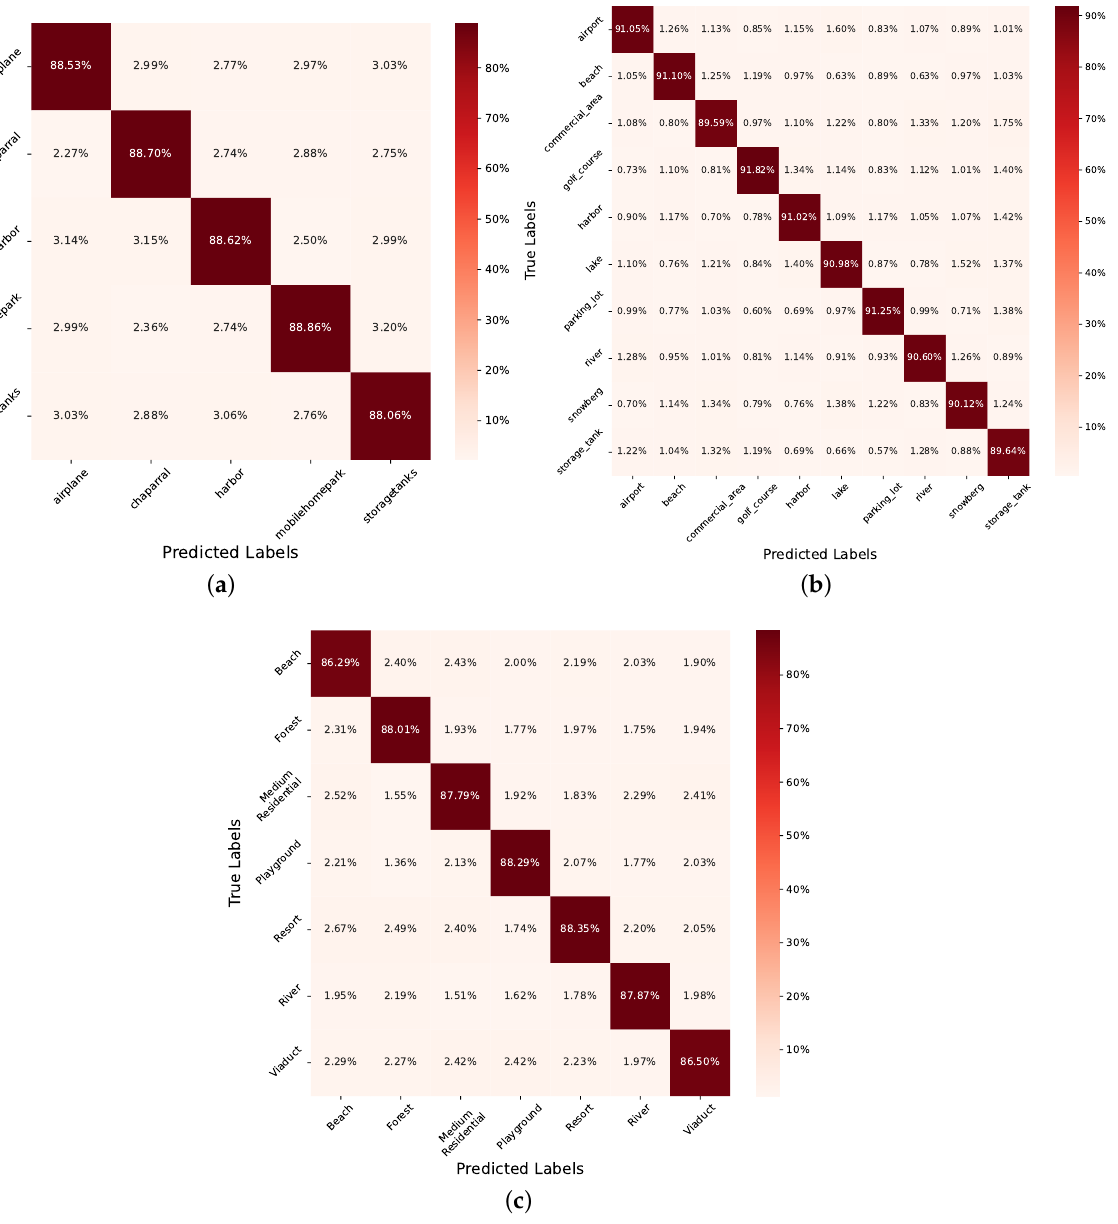
Figure 10. Classification confusion matrix on datasets. ( a ) Classification confusion matrix on dataset UC Merced; ( b ) Classification confusion matrix on dataset NWPU-RESISC45; ( c ) Classification confusion matrix on dataset